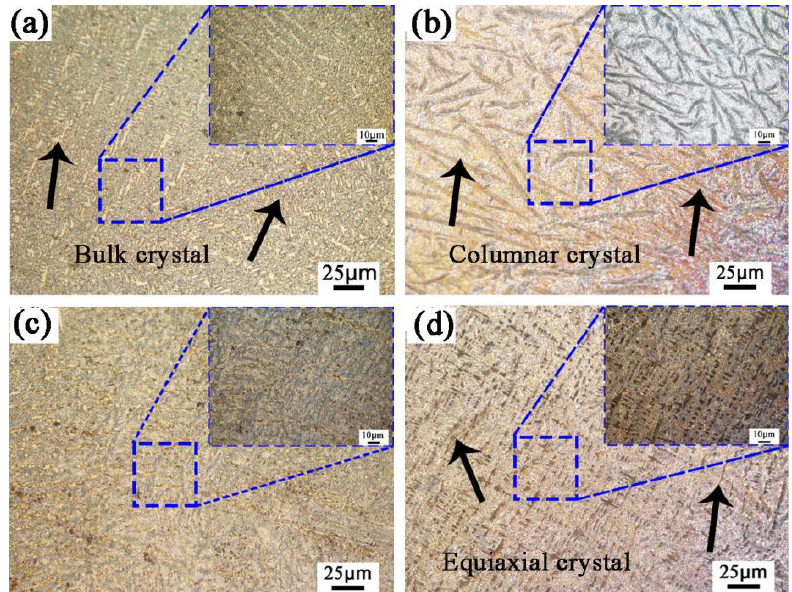
Figure 1. The microstructures of composite coatings of non-thermal treatment and thermal- treatment samples: ( a ) 25 °C-2%CeO 2 ; ( b ) 500 °C-2%CeO 2 ; ( c ) 600 °C-2%CeO 2 ; ( d ) 700 °C-2%CeO 2 .